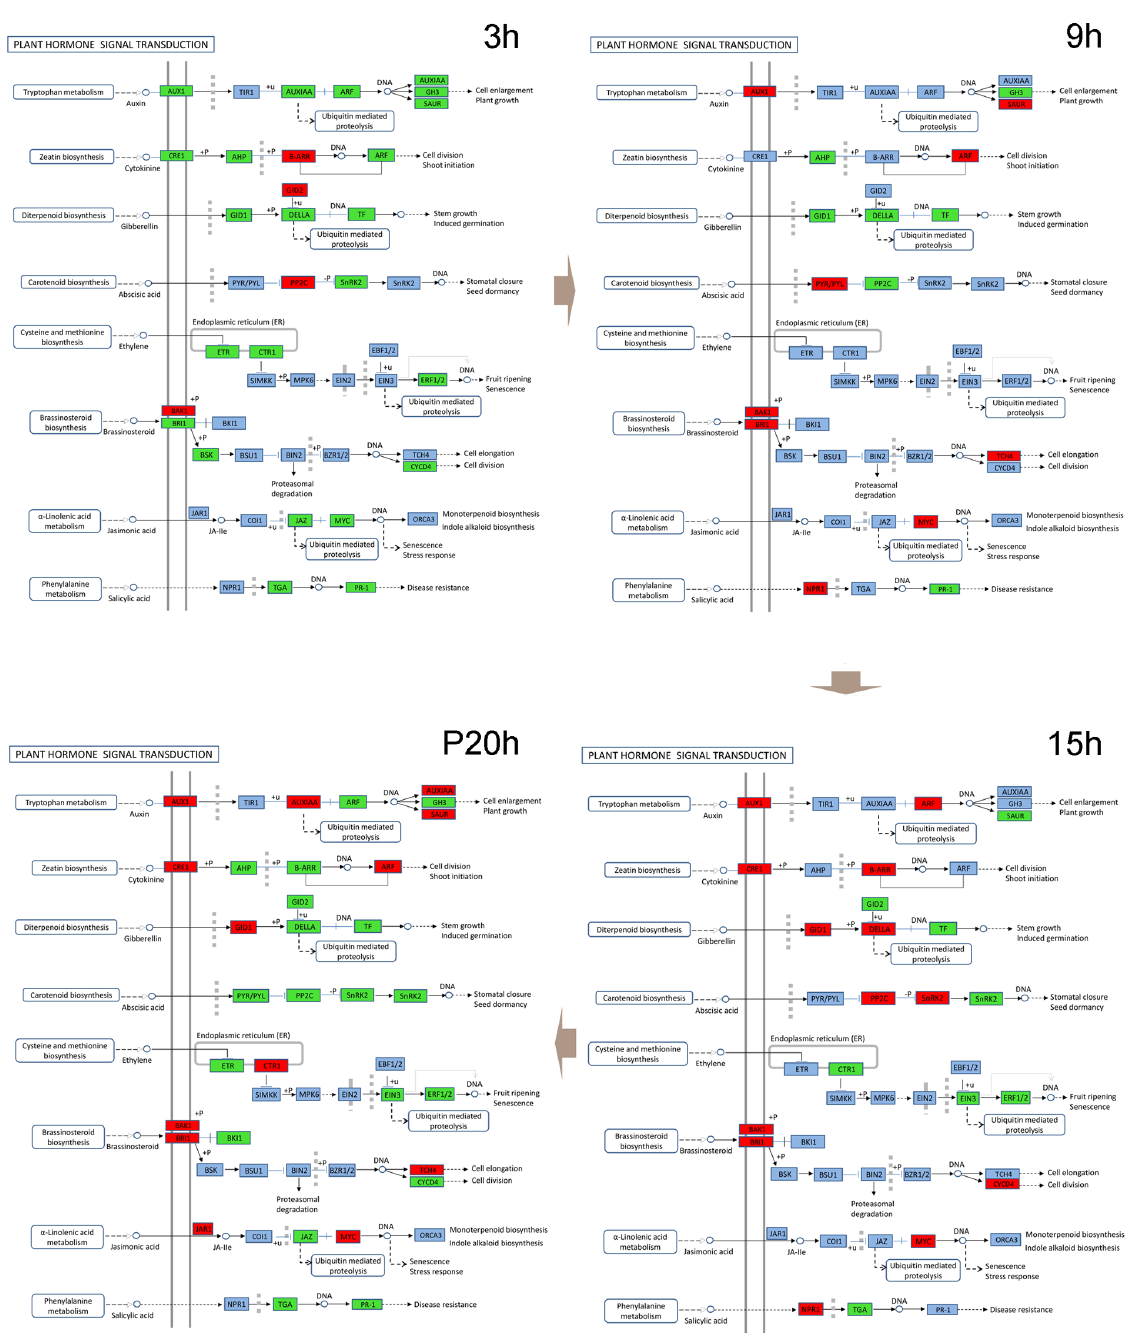
Fig 5. Locations of DEGs between WT and WS in the plant hormone signal transduction pathway. Red indicates the genes upregulated in WT compared with WS plants, and green indicates the downregulated